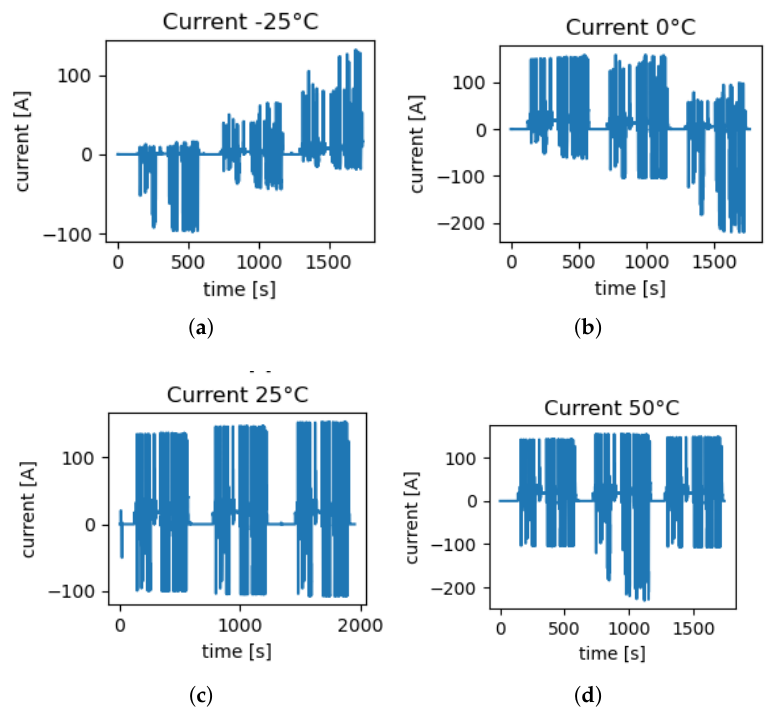
Figure 6. Currents in test set at a temperatures of: − 25 °C ( a ); 0 °C ( b ); 25 °C ( c ); and 50 °C ( d ).